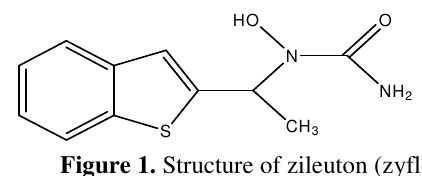
Figure 1. Structure of zileuton